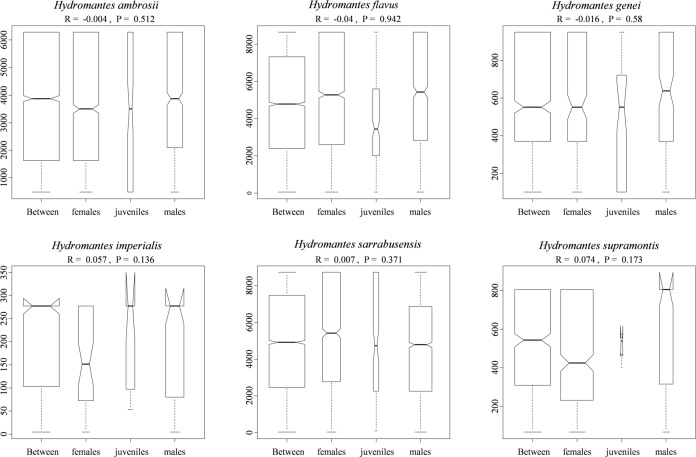
Box whisker plot of ANOSIM analysis comparing the diet of males, females and juveniles per studied species and season.Boxes indicates values from 25th (bottom) to 75th (top) percentile; horizontal black line indicate the median; box width is proportional to sample size.